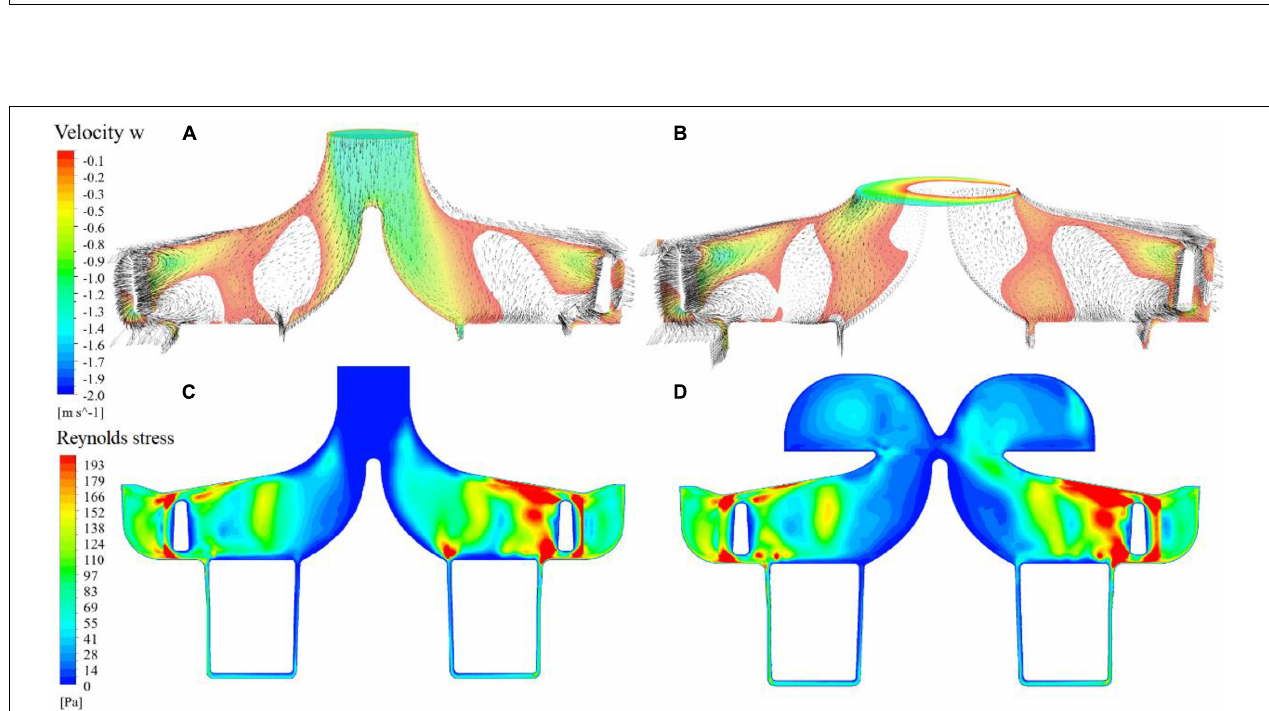
FIGURE 7 | Negative axial velocity contours at the meridional plane and cavity/impeller interface for the baseline and portable pumps (A,B) ; contours of Reynolds stress at the meridional plane for the baseline and portable pumps (C,D) .